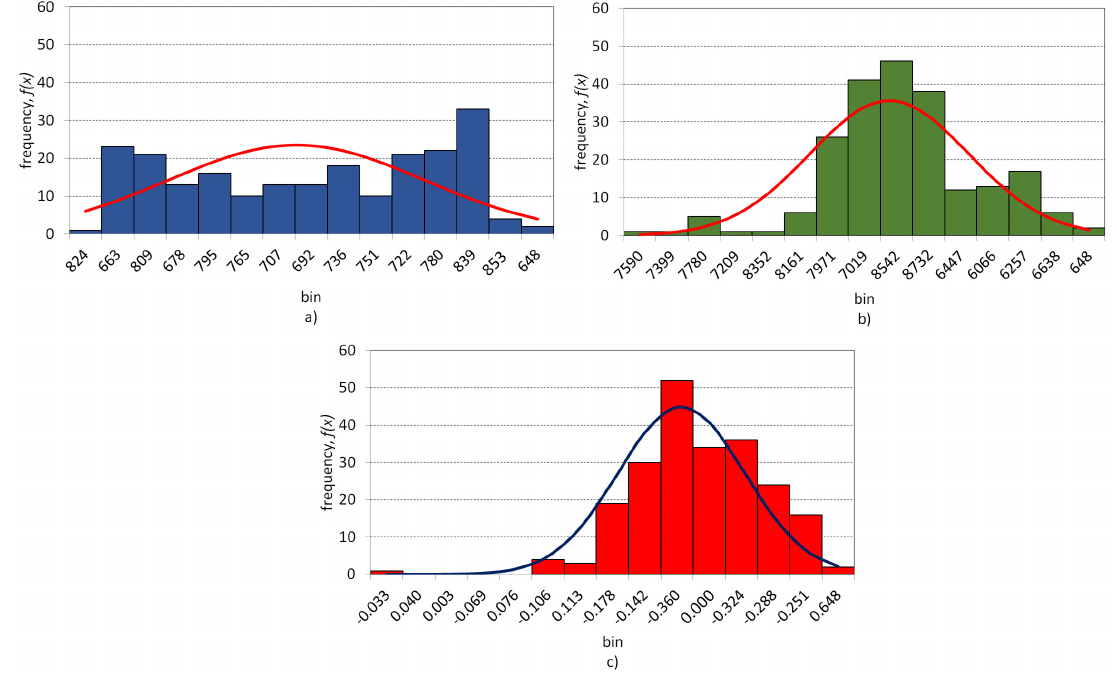
Figure 8. Histograms of measured parameters, ( a ) process revolutions, ( b ) pressure force, ( c ) vibration signal of